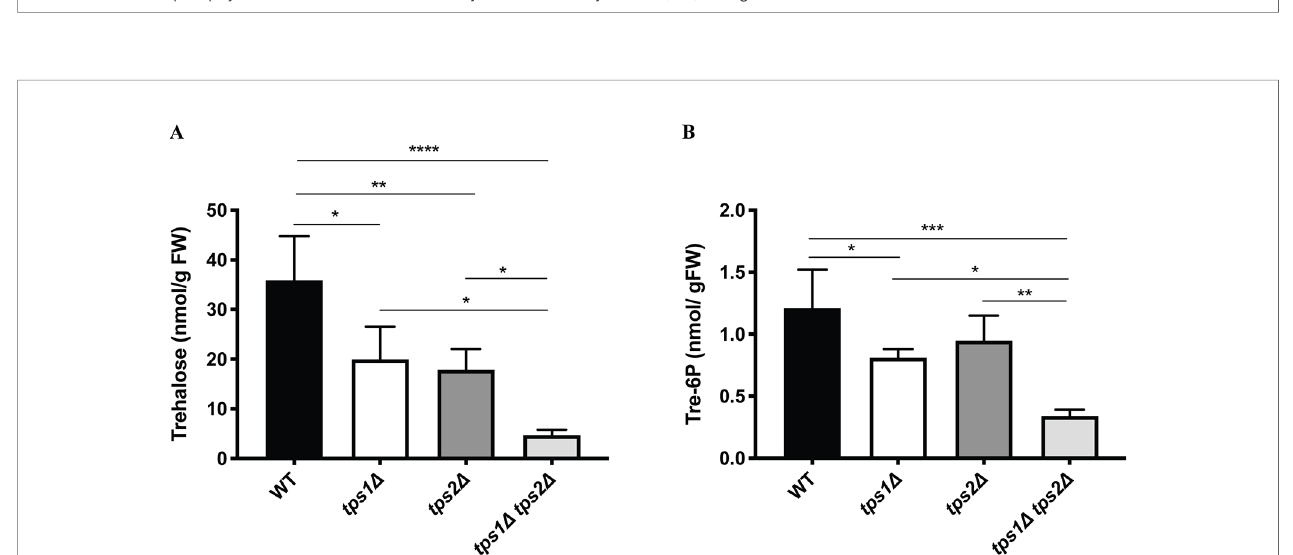
FIGURE 9 | Measurement of trehalose (A) and trehalose-6-phosphate (B) levels in wild-type (WT) and transgenic plants. Data represent mean ± SD of four biological replicates. Statistical analysis with one-way ANOVA. *p ≤ 0.05, **p ≤ 0.01, ***p ≤ 0.001, ****p ≤